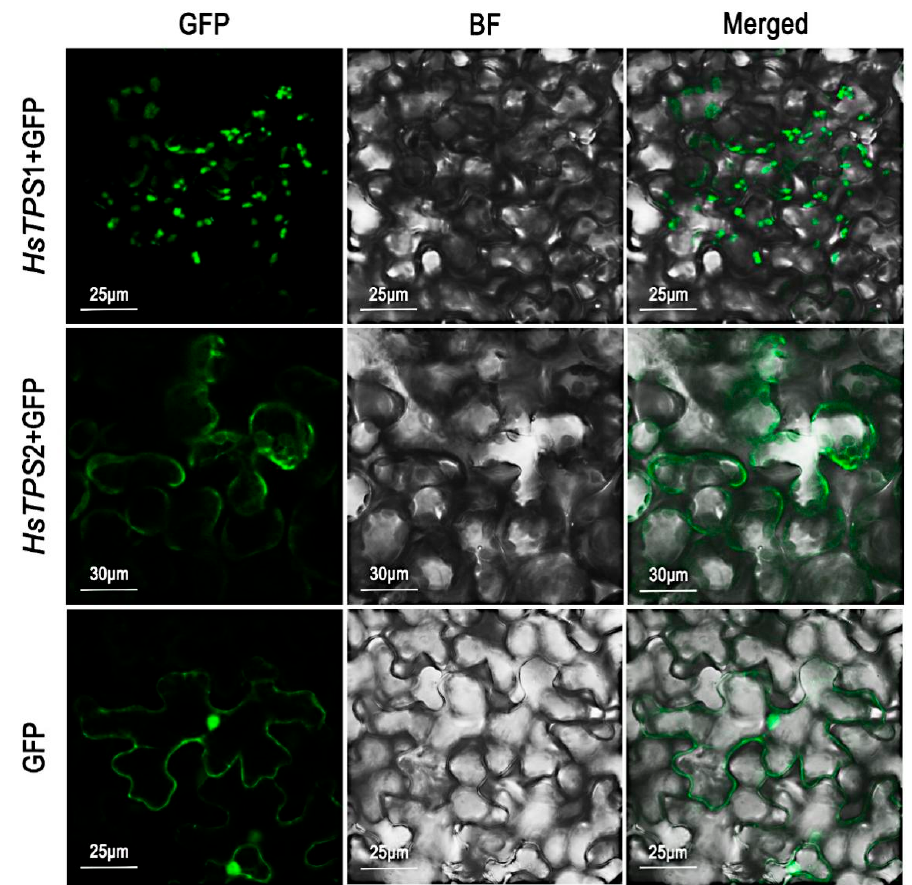
Figure 6. Subcellular localization of Hs TPS1 and Hs TPS2 by transient transformation of N. bentham- iana with Agrobacterium carrying a pCambia 1300 expression vector, where the Hs TPS1 and Hs TPS2 coding sequence was fused with the GFP coding sequence, respectively. GFP, GFP fluorescence de- tected in the green channel; BF, brightfield image; Merged, merged green and BF channel images.